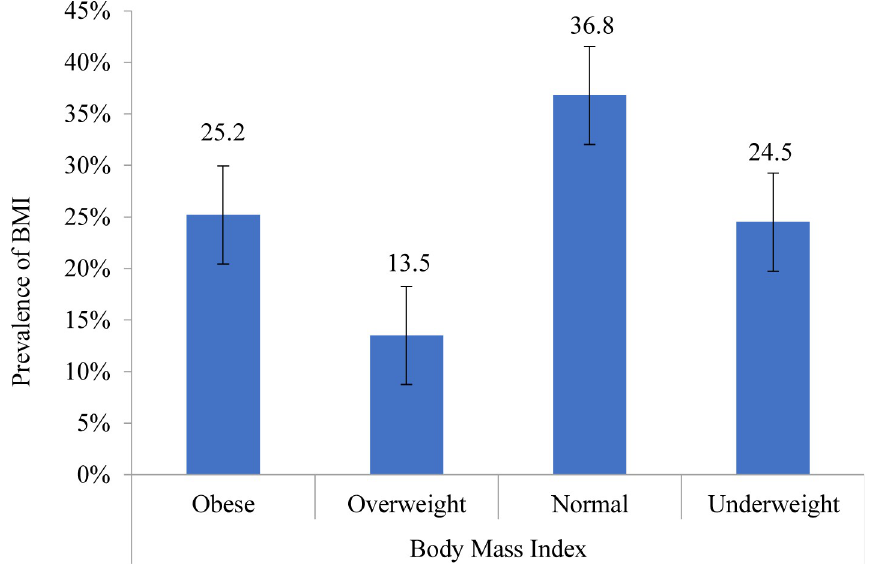
Fig 3. Anthropometric assessment of school